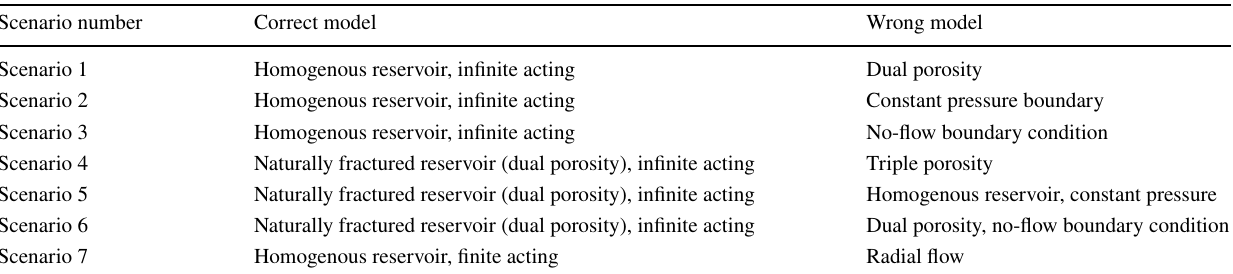
Table 4 Summary of